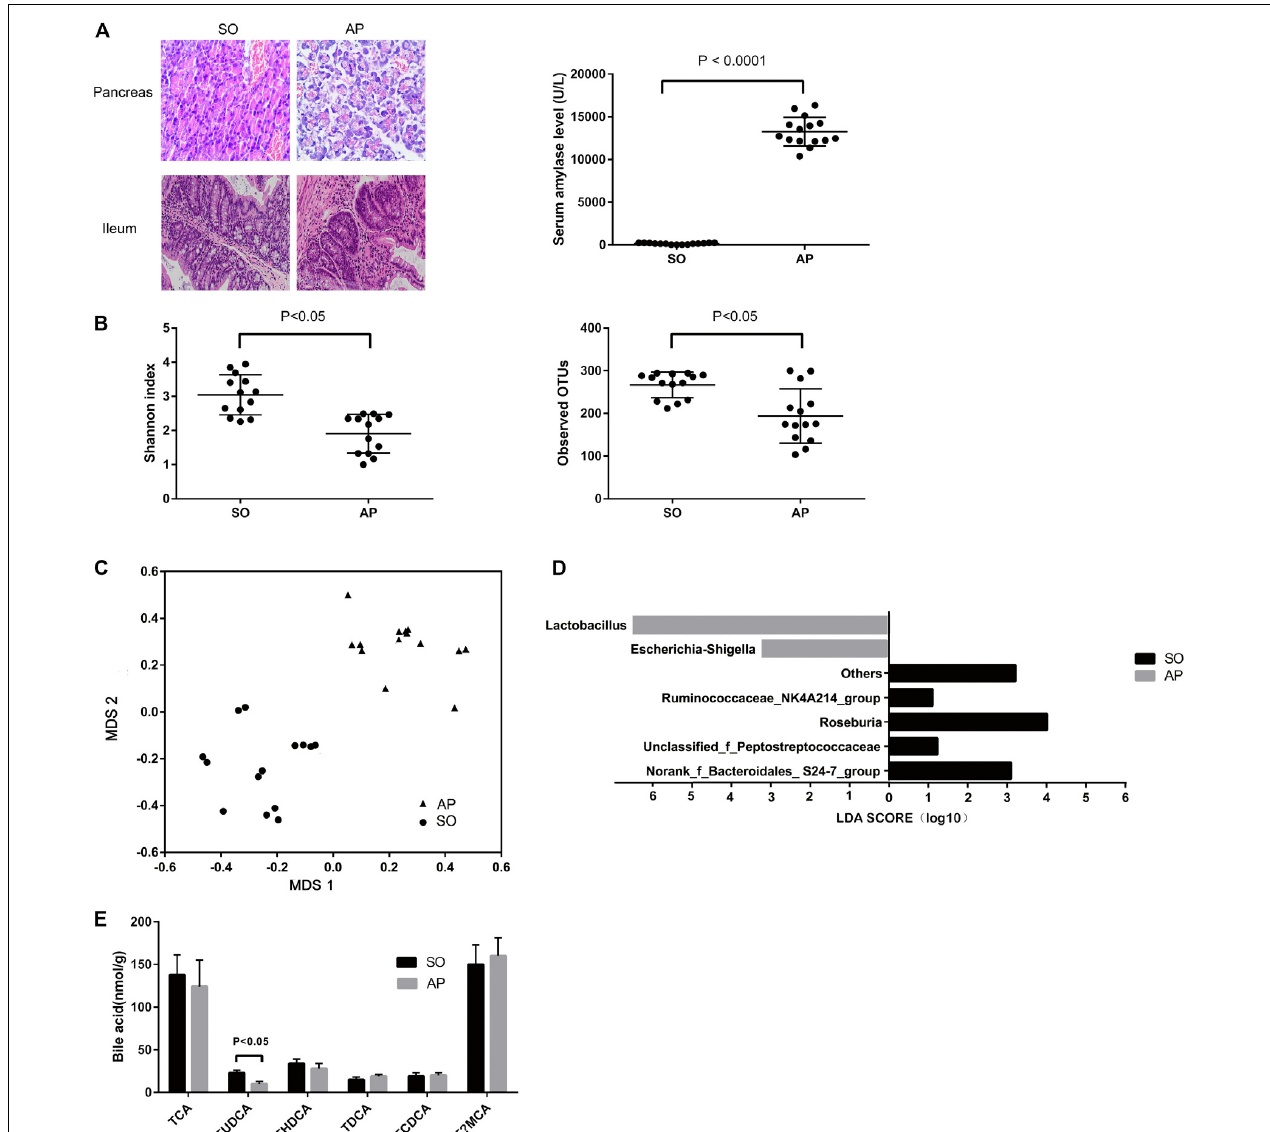
FIGURE 1 | Gut microbiota and bile acid metabolism changes in AP mice. (A) Histological analysis of the pancreas and ileum, and analysis of serum amylase levels in sham-operated (SO) and acute pancreatitis (AP). (B) The Shannon diversity index and numbers of observed OTUs (a-diversity) are different between AP and SO. (C) Non-metric multidimensional scaling method showing a definite shift in gut microbiota composition between AP and SO. The horizontal axis represents the first dimension and the vertical axis represents the second dimension. (D) Linear discriminant analysis scores for the bacterial taxa differentially abundant between acute pancreatitis and the sham-operated group. Only the taxa having a p value < 0.01 and LDA > 2.0 were shown. (E) Stool bile acid levels in the SO and AP